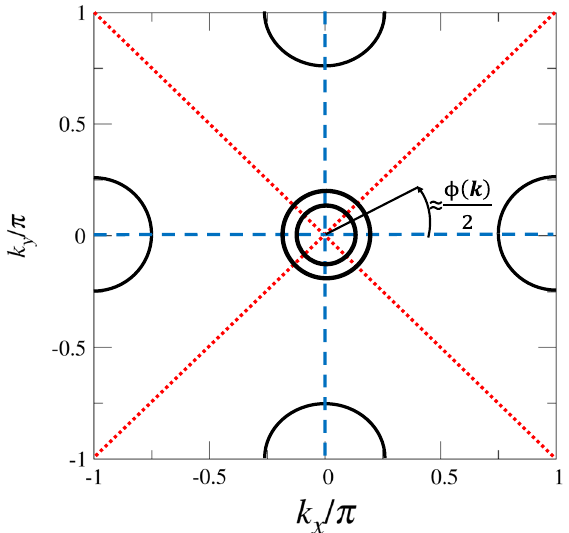
Fig. 1 Schematic illustration of the two-orbital s τ 3 pairing in a 1-Fe Brillouin zone (BZ), which is obtained by unfolding the 2D crystallographic BZ cell in the conventional manner. 55 The solid lines indicate typical Fermi pockets for the Fe-based superconductors. The dotted , red lines indicate the zeroes speci fi c to the intraband pairing ( ξ − ), while the dashed , blue lines mark the zeroes speci fi c to the interband pairing ( ξ xy ). The intra- and interband components do not vanish at the same subset of k , ensuring that there is always a non-zero pairing given by either of the two components on the entire Fermi surface. For max( ξ − ) ≈ max( ξ xy ) the angle ϕ ( k ) (Eqs 5 – 7) can be roughly identi fi ed with twice the winding angle shown for fi xed | k | . In addition, there is a sign change between the intraband pairing along the two pockets at the edge of the BZ, a condition necessary to the formation of a resonance in the spin-excitation spectrum at the wavevector q = ( π , π /2) observed in experiment.